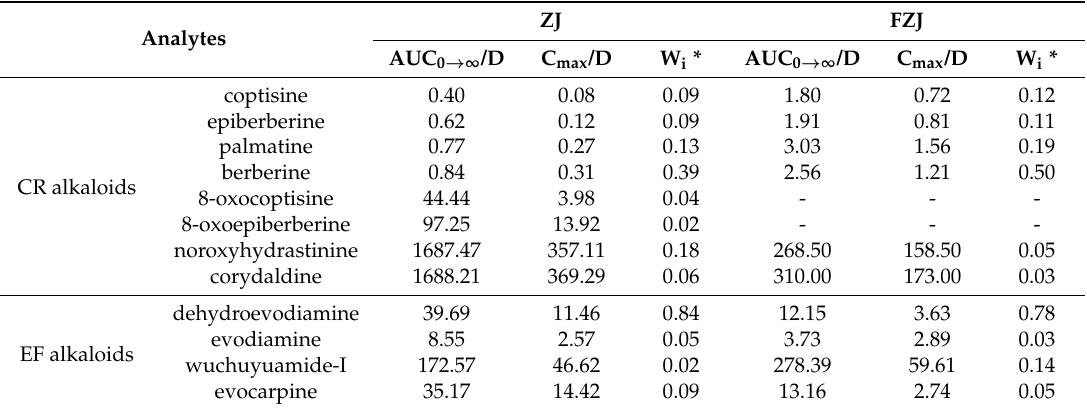
Table 3. Dose modified AUC 0 → ∞ , C max and AUC weighted factors (W i ) of the 12 alkaloids in rat plasma after oral administration of ZJ and FZJ